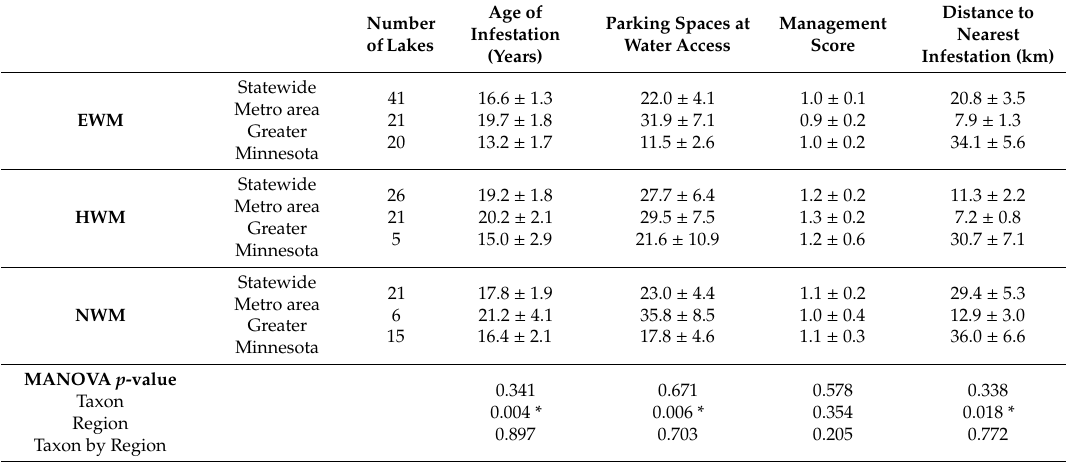
Table 5. Mean values and standard errors for infestation-associated variables of lakes classified as containing either Eurasian (EWM), hybrid (HWM), or northern (NWM) watermilfoil and p -values for taxon, region, and taxon by region.